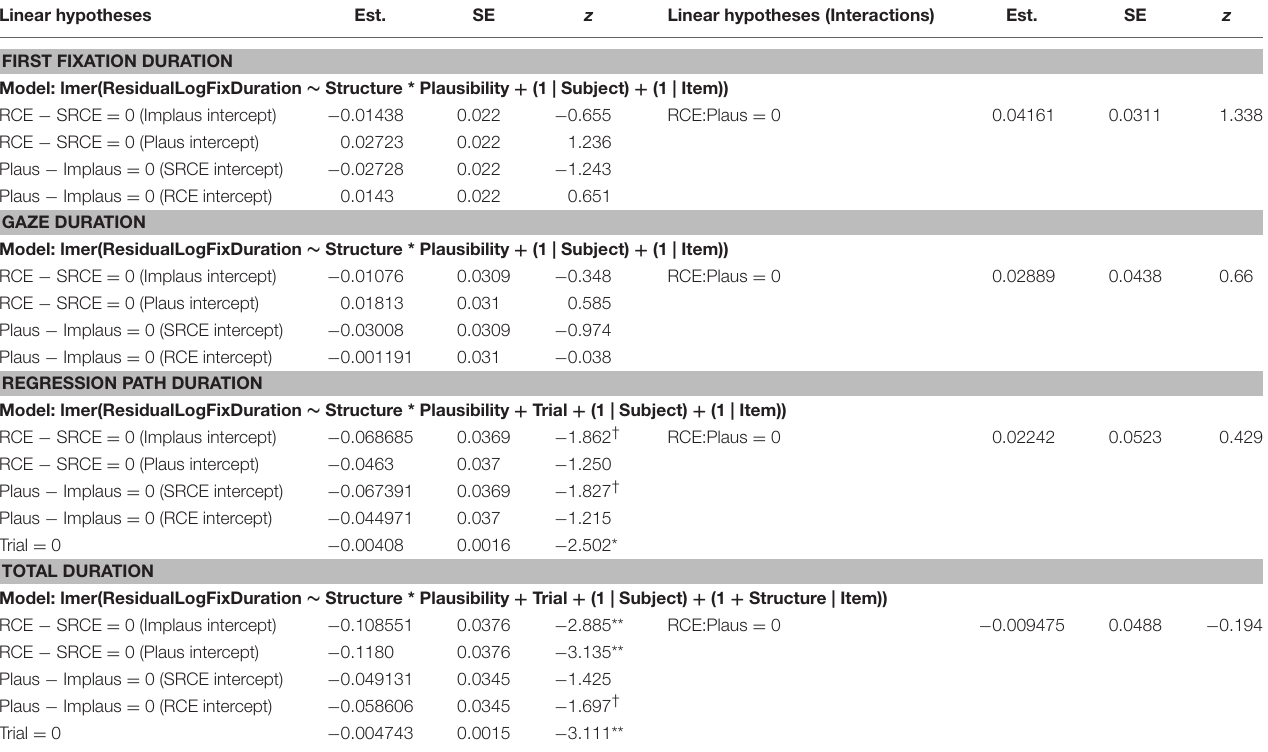
TABLE 8 | Experiment 2 R02 (PP): Simultaneous tests for general linear hypotheses for linear effects models fitted to log-transformed and residualized fixation durations. Linear